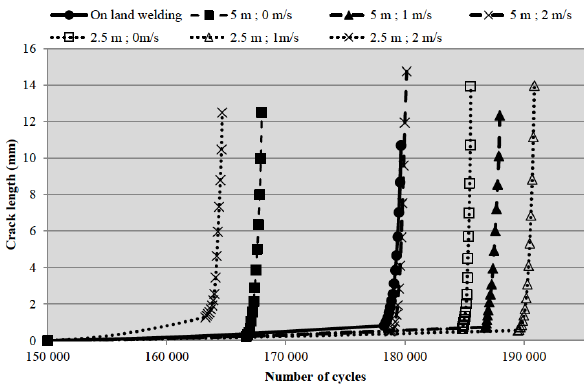
Figure 7: Relationship between crack length (a) and the number of cycles (N) of the underwater wet welded joint.